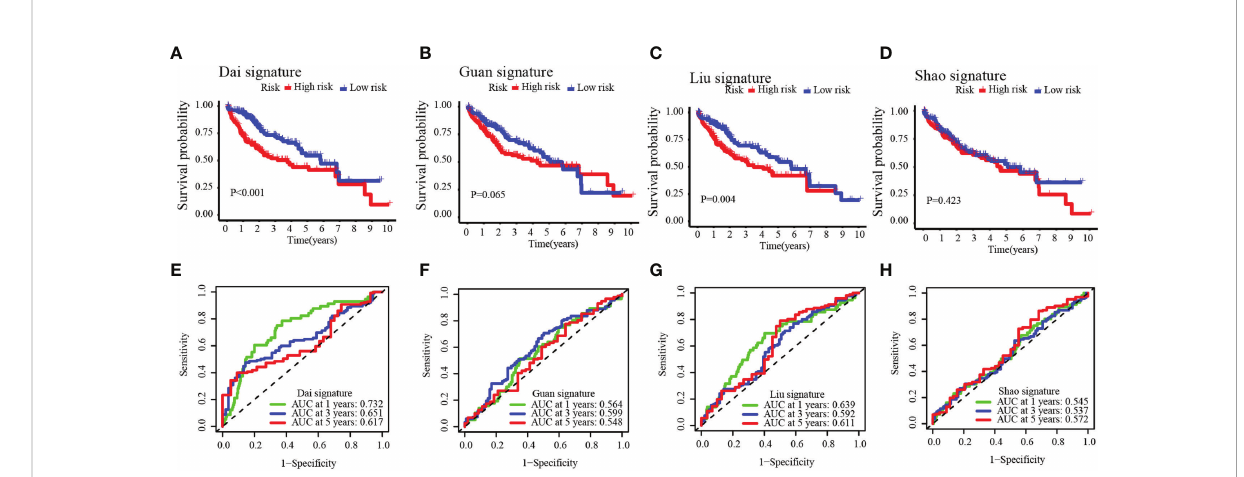
FIGURE 7 Four other prognostic models in the TCGA-HCC cohort (A – D) and time-dependent ROC curves (E – H)